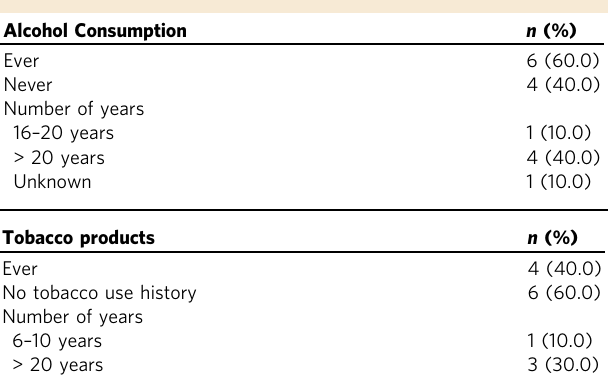
Table 2 Alcohol and tobacco consumption history of the enrolled